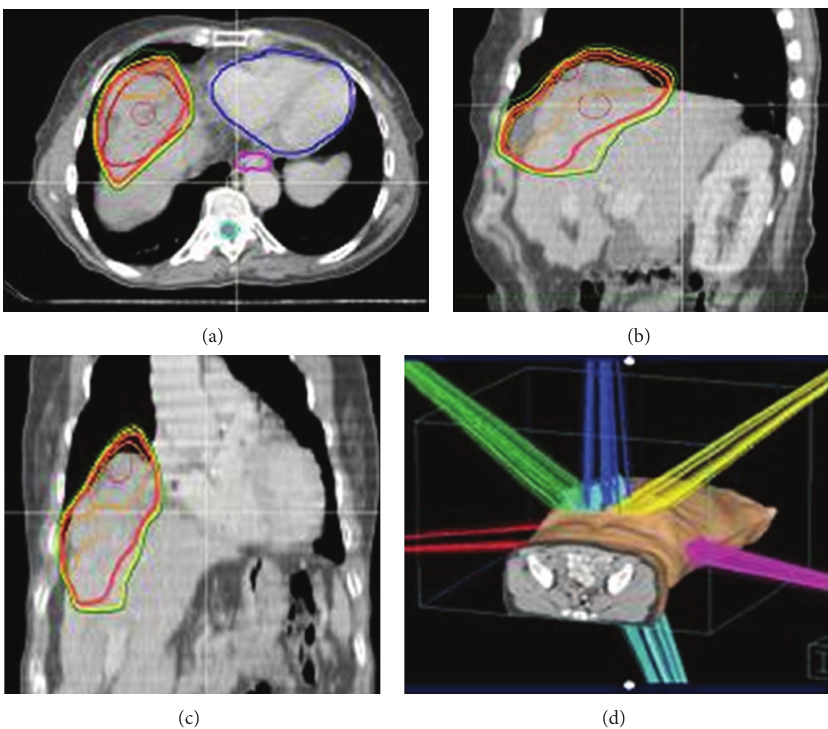
Figure 1: HSRT treatment plan: the axial (a), sagittal (b), coronal (c), and three-dimensional view (d). Red line: 100% isodose line; Yellow line: 95% isodose line; green line: 80% isodose line.